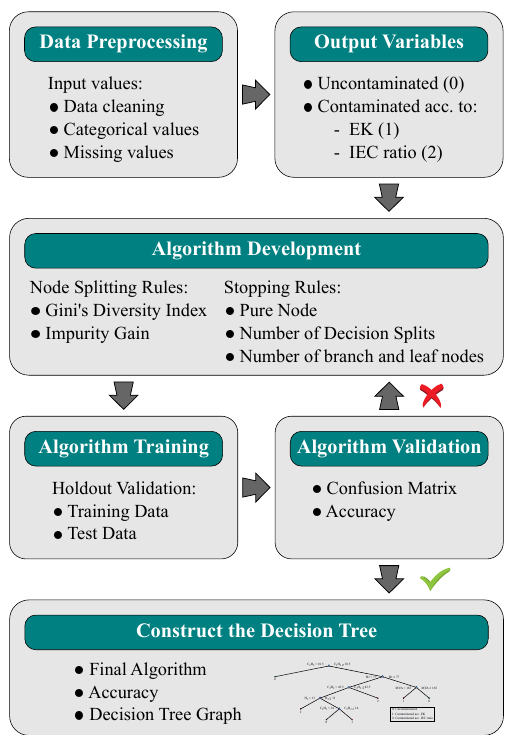
Figure 10. Machine learning methodology